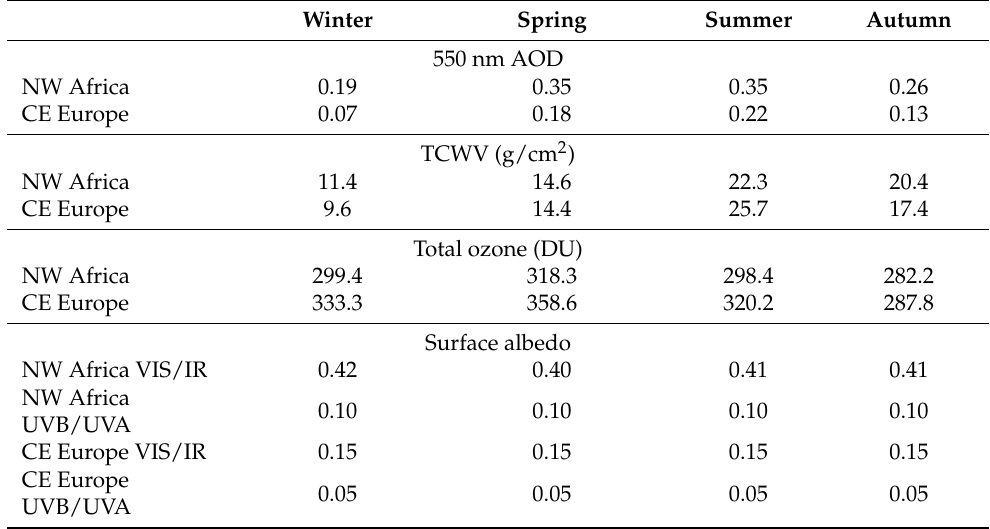
Table 2. TCO, TCWV, surface albedo and AOD at 550 nm used in the simulations for NW Africa and CE Europe.